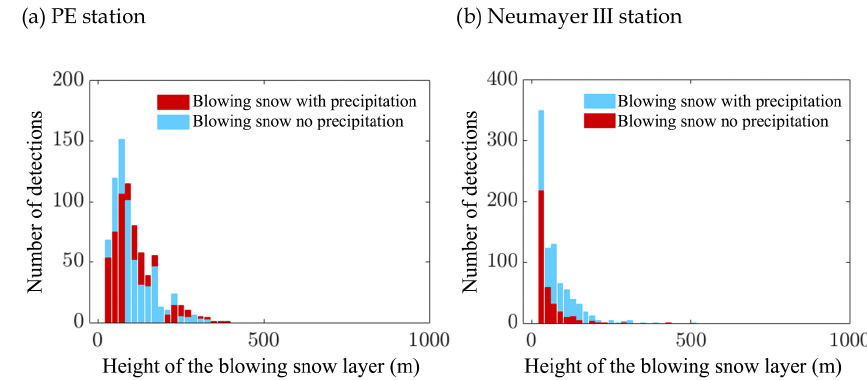
Figure 11. Distribution of the height of the blowing snow layer at (a) PE station (b) at Neumayer station, blowing snow accompanied with precipitation in blue, blowing snow without precipitation in red.